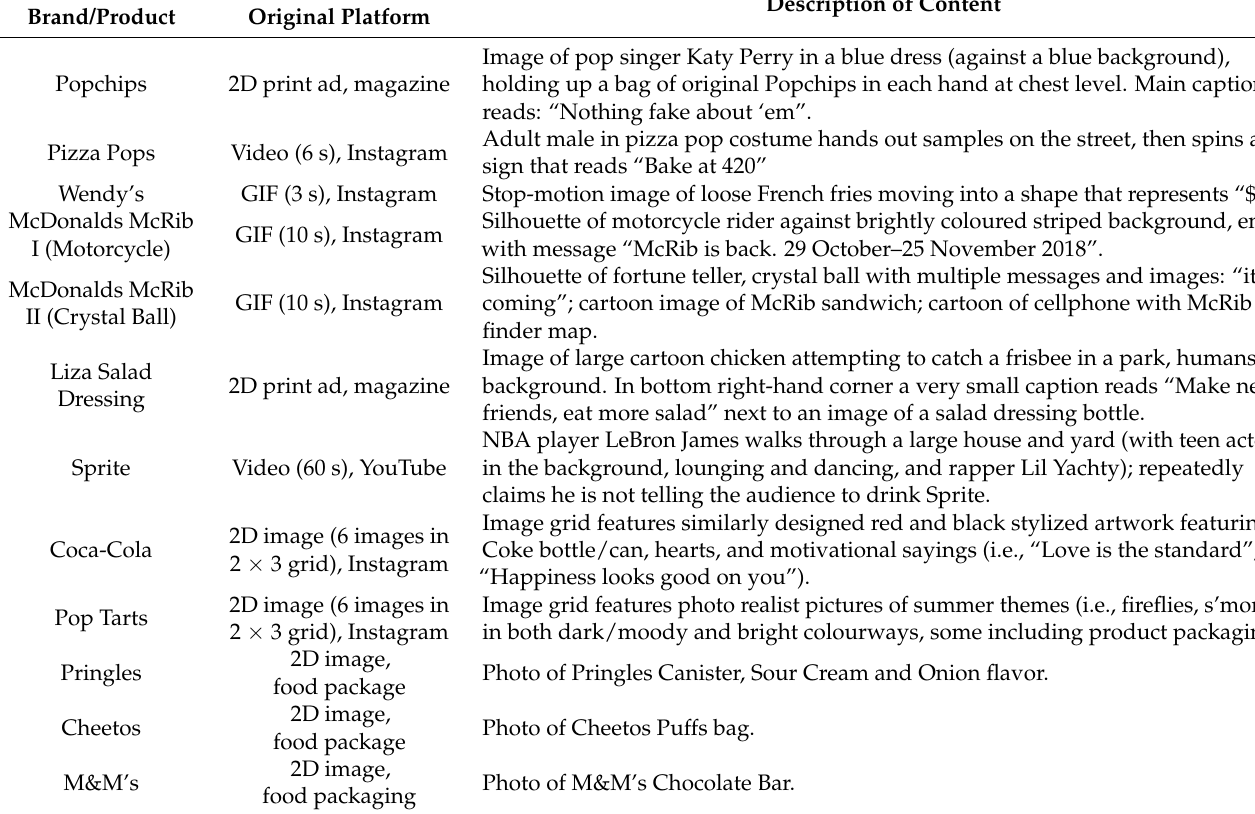
Table 1. Food marketing examples selected for teen-targeted indicators testing.